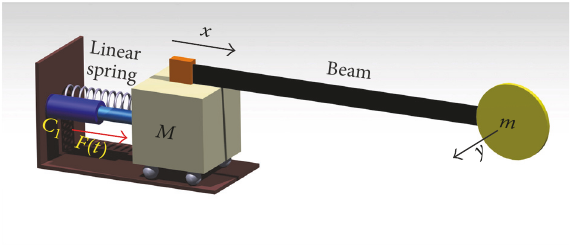
Figure 1: Schematic diagram of the primary system with autopara- metric